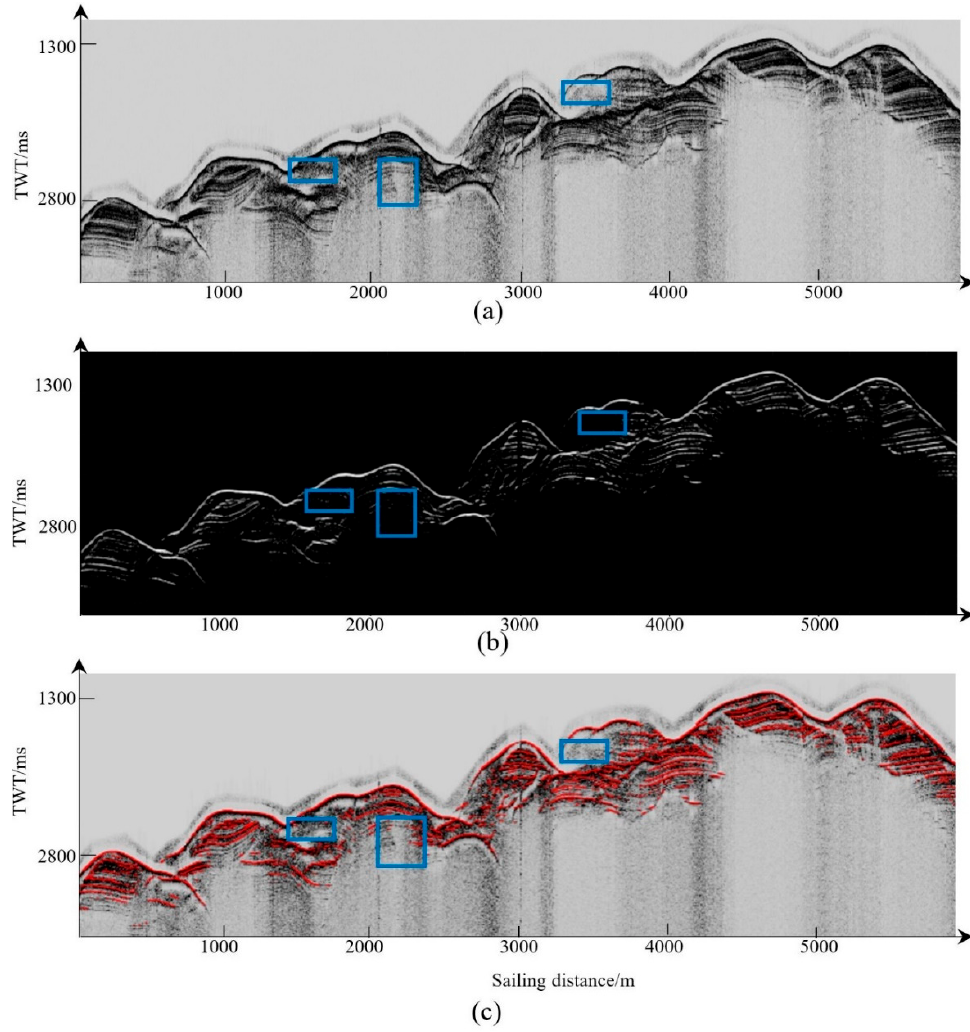
Figure 13. The original SBP image and the resulting images. ( a ) shows the original SBP image. ( b ) shows the filtered image. Picking horizons from ( b ), ( c ) shows the superposition of picked horizons and the original SBP image. Blue boxes show the areas having acoustic turbidities or acoustic blanks.